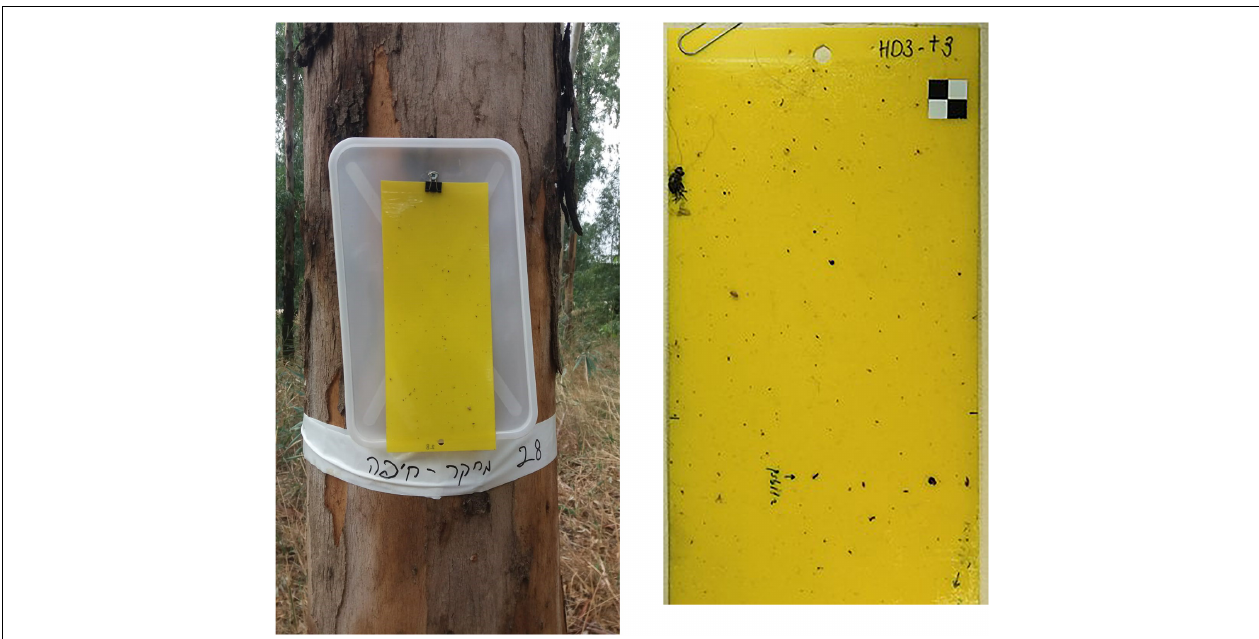
FIGURE 1 | Left – example of a sticky trap attached to a Eucalyptus trunk. Right – image of a trap with a checkers target. A G. brimblecombei psyllid is marked with an arrow. Numerous other insects were captured, including flies, mosquitoes, and thrips.